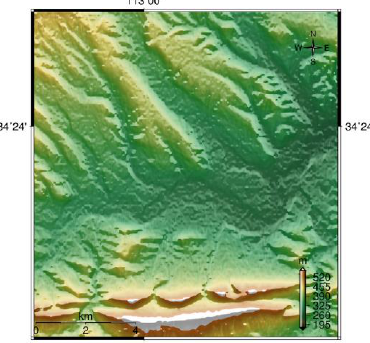
Figure 3. SRTM DEM of the study area